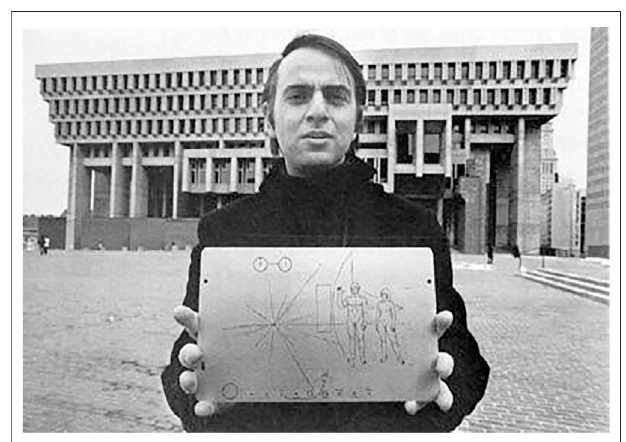
FIGURE 1 | Carl Sagan holding the Pioneer plate. Credit: